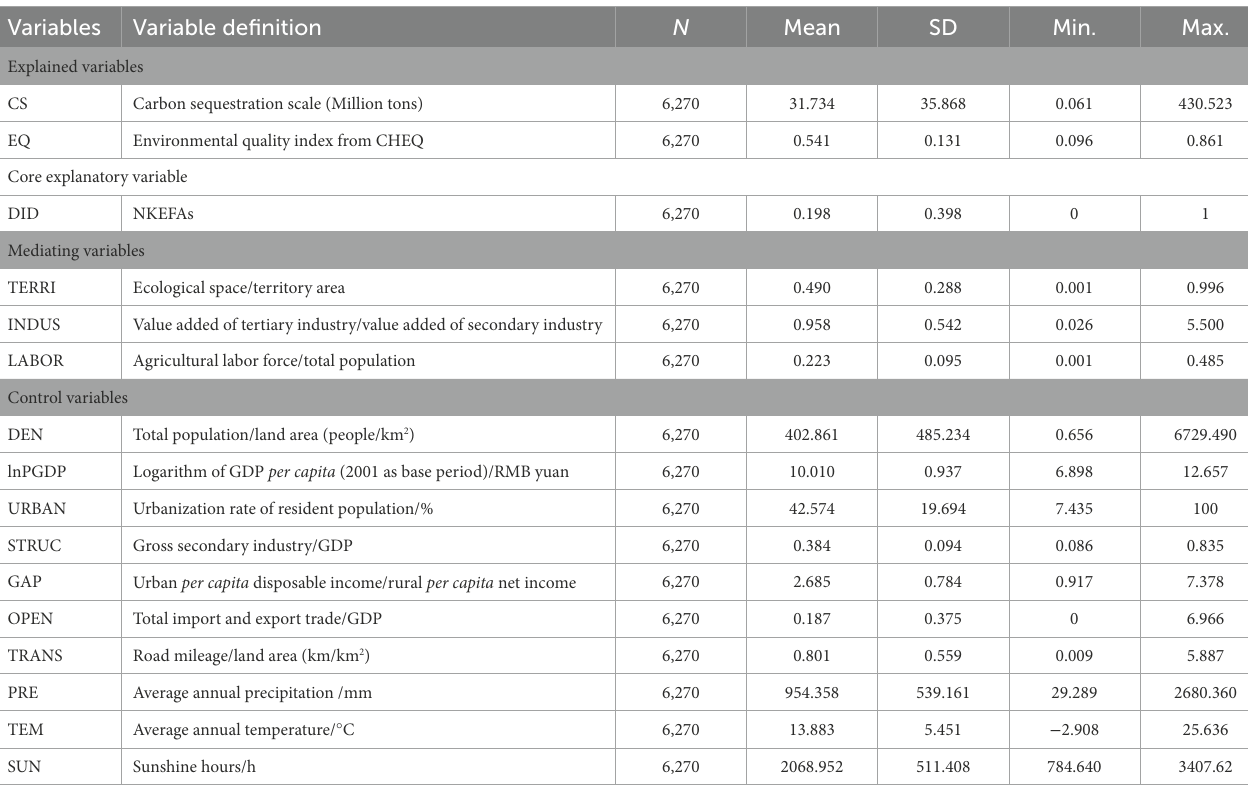
TABLE 1 Descriptive statistics of the